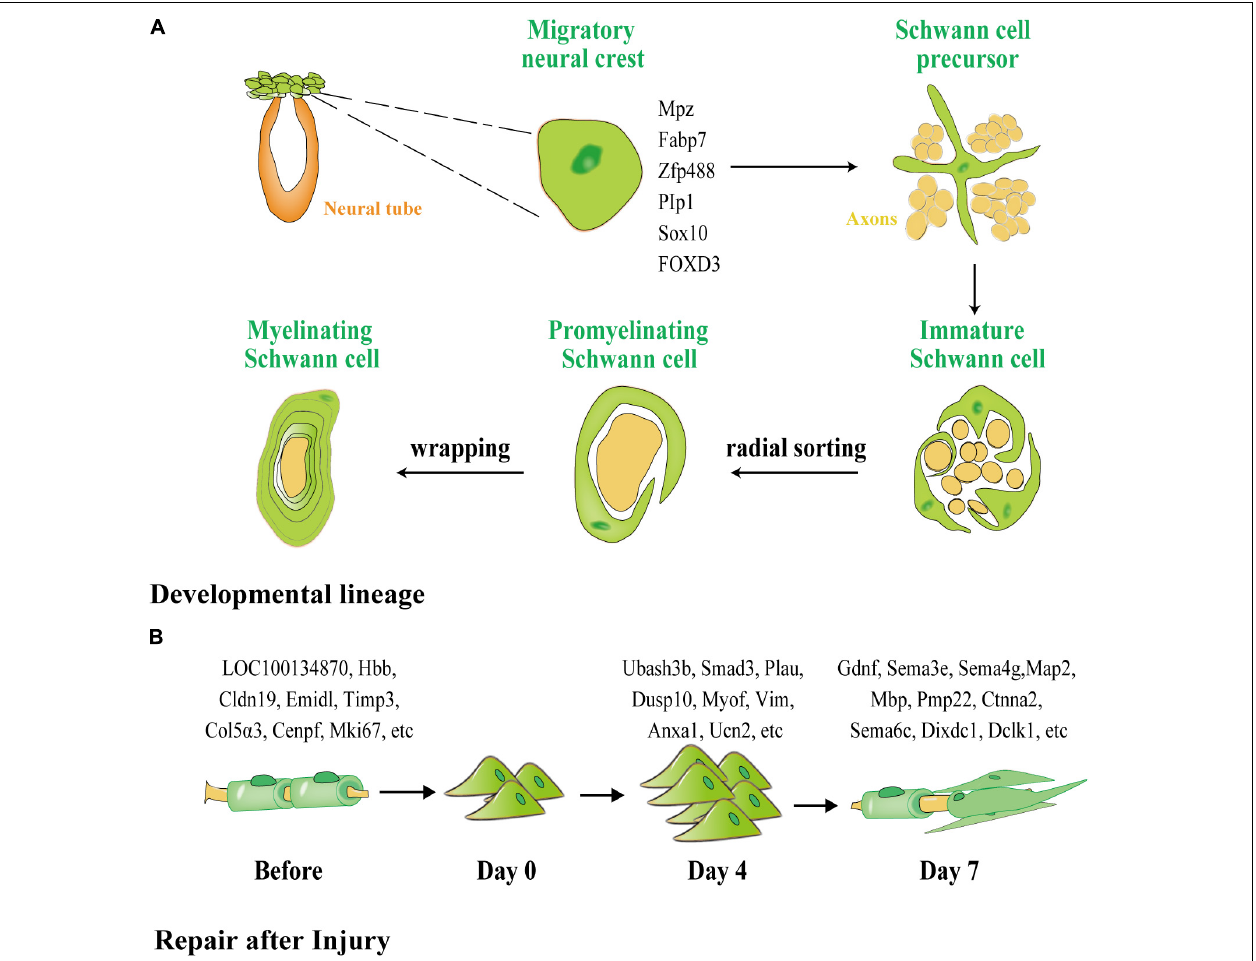
FIGURE 2 | The different processes of myelination of SCs during development and after peripheral nerve injury (PNI). (A) SCs generated from neural crests create myelin sheaths in the PNS. Green represents glial cells and precursors, and orange represents the neural tube and yellow represents neurons and their axons. SCPs are neural crest cells that detach from the neural tube and migrate along the nascent peripheral axons, expressing the early glial markers Mpz, Fabp7, Zfp488, Plp1, Sox10, and forkhead box D3 FOXD3. SCPs differentiate into immature SCs, which, via cytoplasmic extension, enclose the axon bundle. Finally, radial sorting is used to choose a single axon for wrapping. SCs that have been myelinated enclosed axon segments, forming myelin sheaths. (B) Dedifferentiation and remyelination of SCs after PNI. Normal SCs form a myelin sheath around axons with one of four phenotypes: subtype 1 expressing LOC100134871 and Hbb, subtype 2 expressing Cldn19 and Emid1, subtype 3 expressing Timp3 and Col5a3, and subtype 4 expressing Cenpf and Mki67. After PNI, SCs transform into a homogenous phenotype and participate in proliferation and phagocytosis. On the fourth day after injury, 776 lncRNAs were unique to the proliferation of SCs. After day 7, 317 lncRNAs were unique to the remyelination of